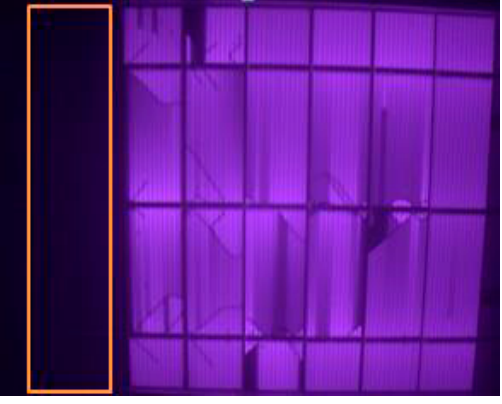
Figure 7. EL test of receiver 1 after the round at 200 °C.